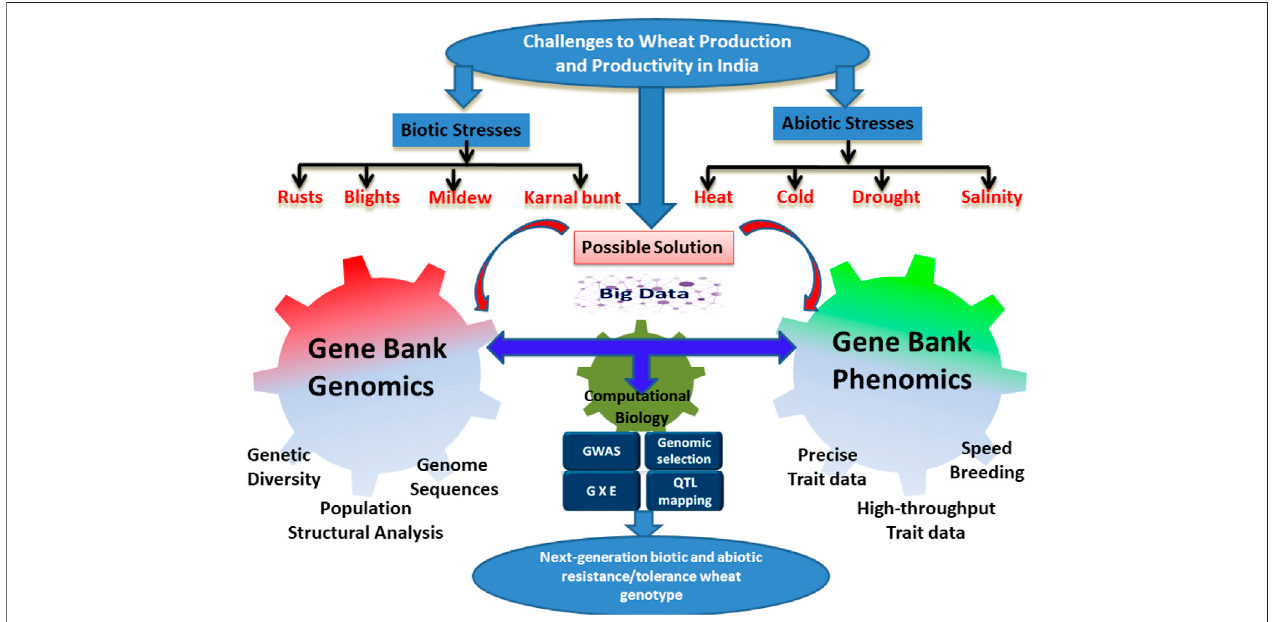
FIGURE 1 | Challenges faced by Indian wheat-breeding programs and the possible solution. The fi gures show different biotic and abiotic stresses limiting wheat production and productivity in India. The fi gures also explain how genomic interventions and gene bank phenomics could be used in development of next-generation wheat varieties with enhanced biotic and abiotic